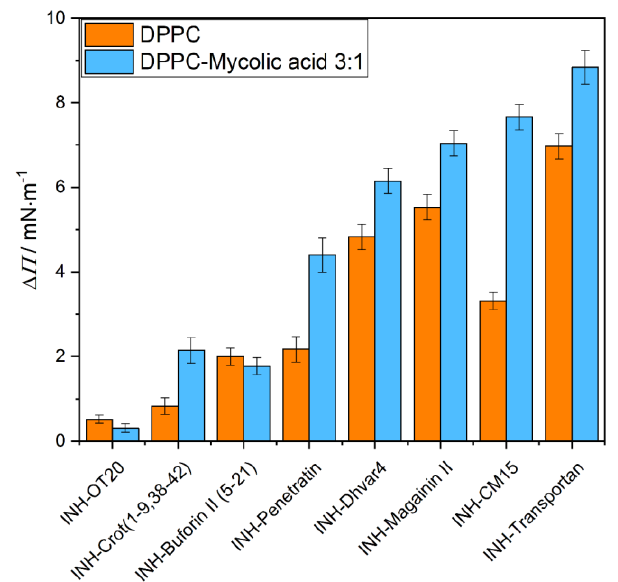
Figure 2. The degree of penetration ( ∆Π ) of isoniazid (INH)-conjugated peptides into DPPC (orange) and DPPC+mycolic acid (3:1 mass ratio) (blue) mixed lipid monolayers after 1 h interaction. (The peptide conjugates are presented according to their increasing R t values.)